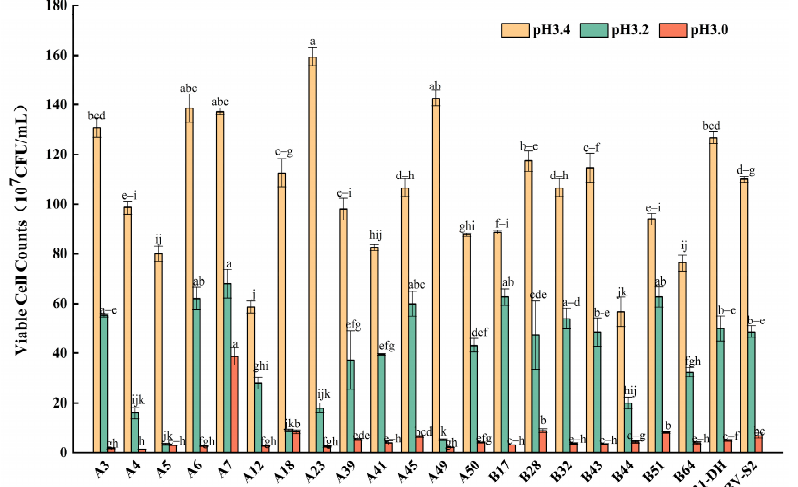
Figure 3. Growth of twenty L. plantarum and control strains in MRS-AJ, which contained pH3.4, 3.2, and 3.0, respectively. Different small letters indicate significant differences according to the LSD Fisher test ( p < 0.05).